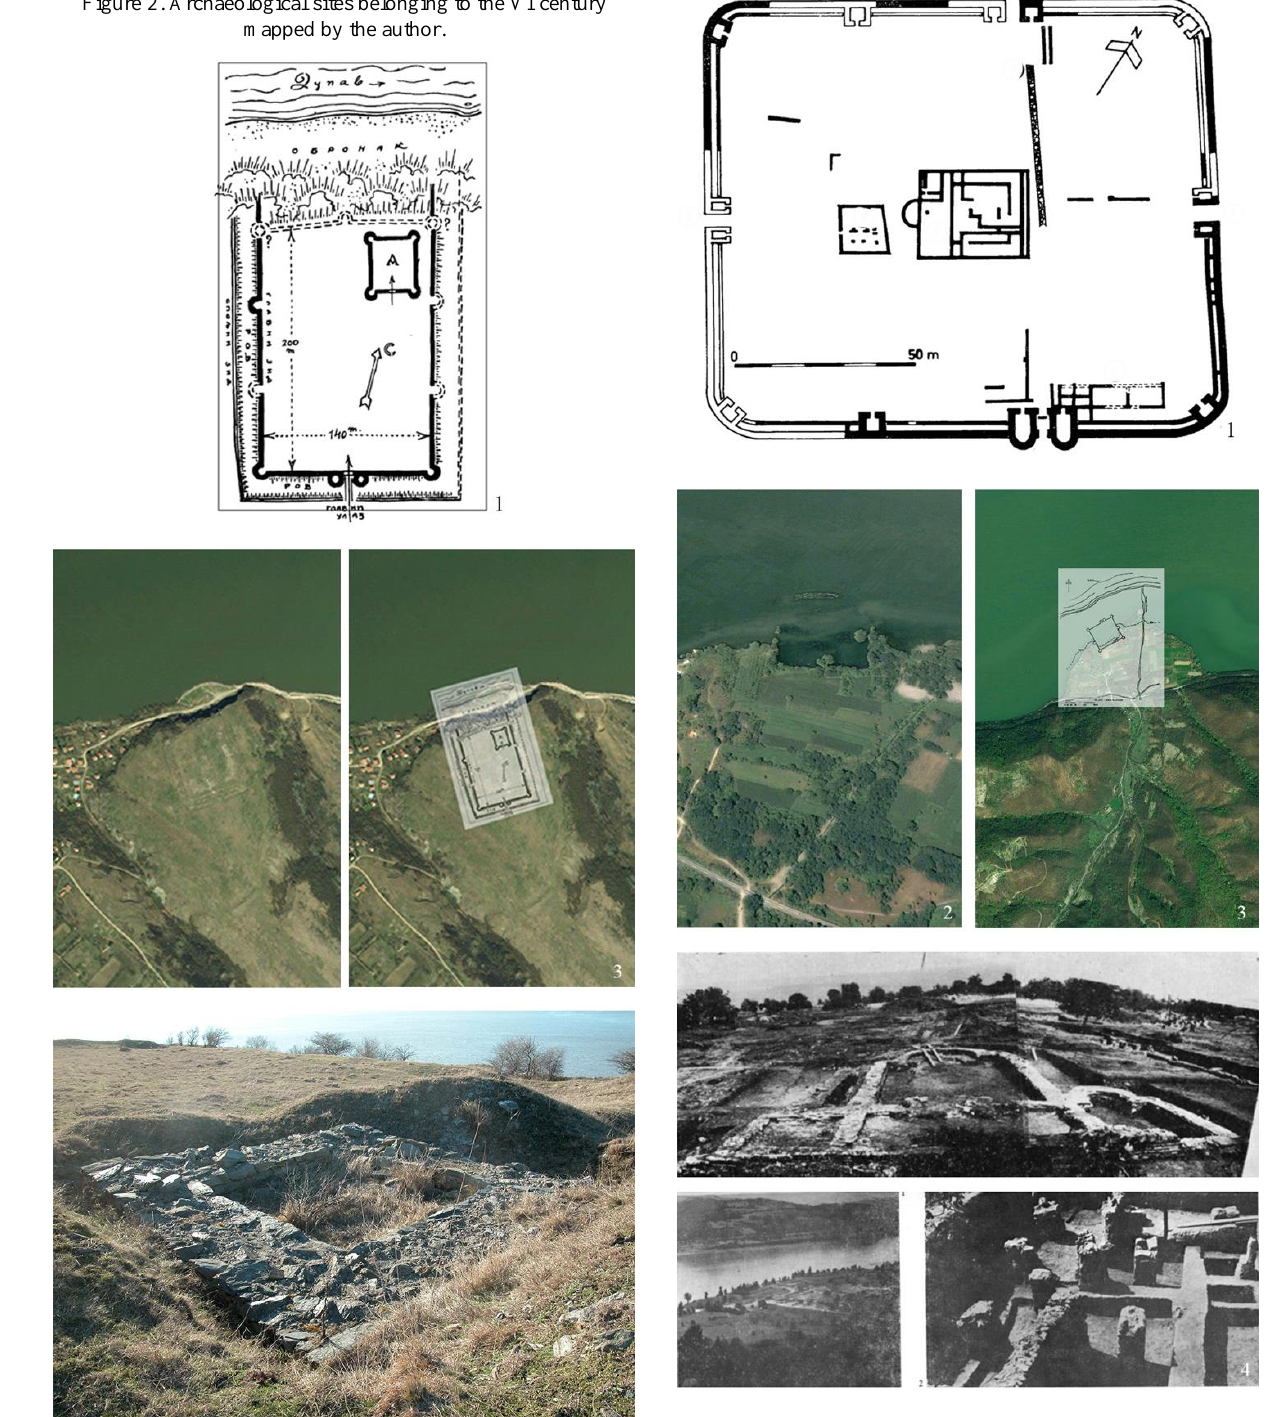
Figure 4. CASTRUM NOVAE 1: plan of the site (VASIĆ, 1983-84); 2: image of the area from Bing Maps. 3: elaboration by the author, Vasić plan on the aereal view of the site. 4: historical photos of the excavations (VASIĆ,